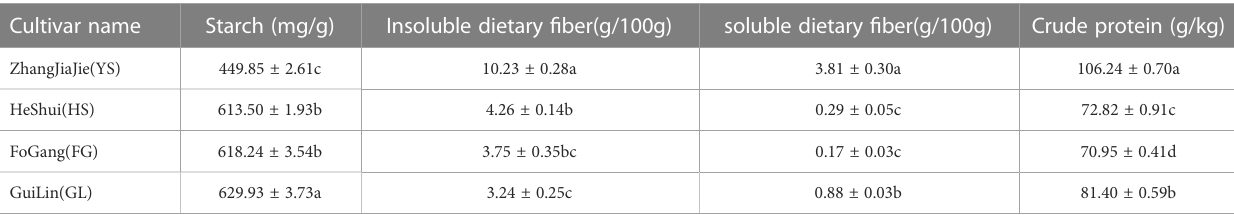
TABLE 2 Starch, soluble dietary fi ber, insoluble dietary fi ber, and crude protein contents in Puerariae Thomsonii and Puerariae Lobatae varieties tested in this study. Cultivar